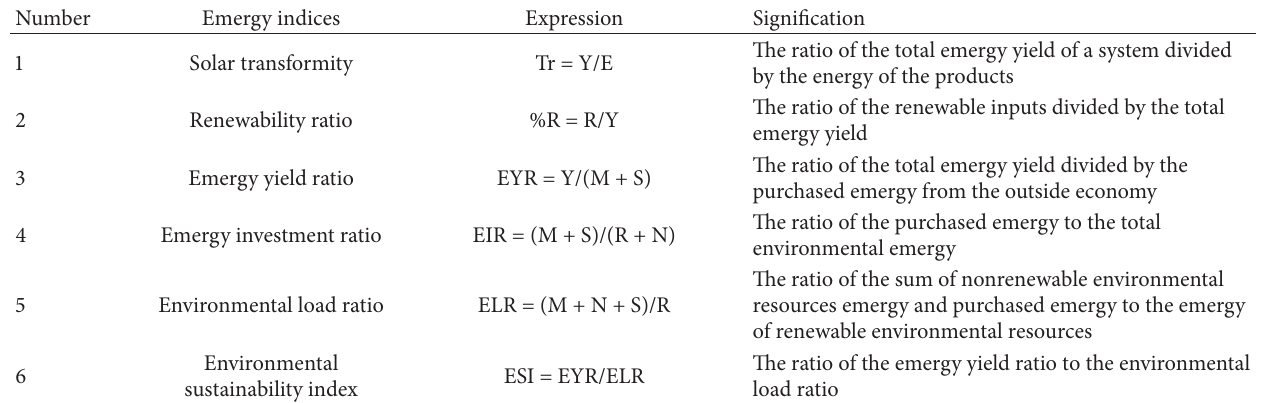
Table 1: Emergy indices used in this